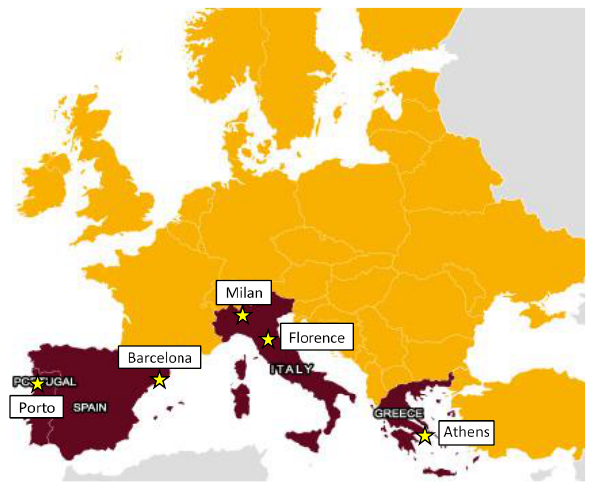
Figure 1. Map of Europe and AIRUSE cities: Porto (Portugal), Barcelona (Spain), Milan and Florence (Italy) and Athens